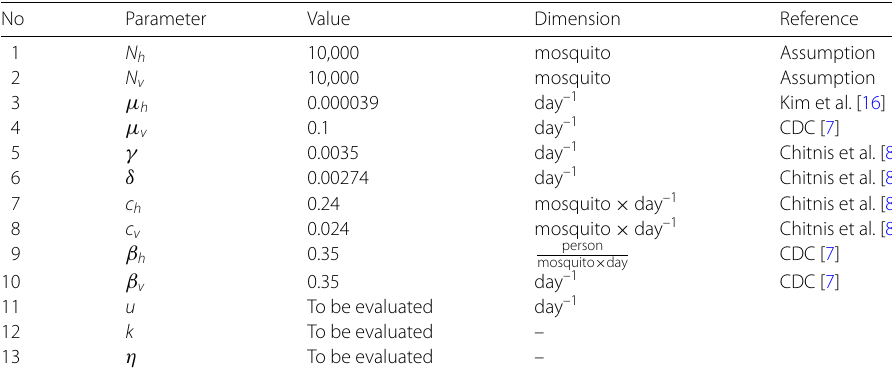
Table 2 Parameter values of SIR-SI model